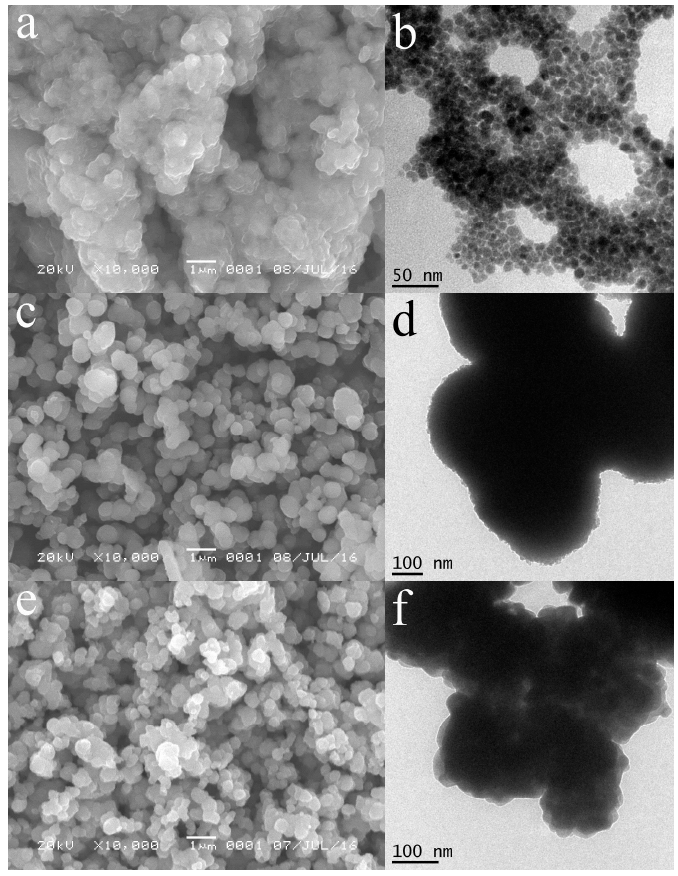
Figure 2. ( a , c , e ) SEM and ( b , d , f ) TEM images of ( a , b ) Fe 3 O 4 magnetic powder, ( c , d ) TiO 2 , and ( e , f ) Fe 3 O 4 /TiO 2 nanocomposites.